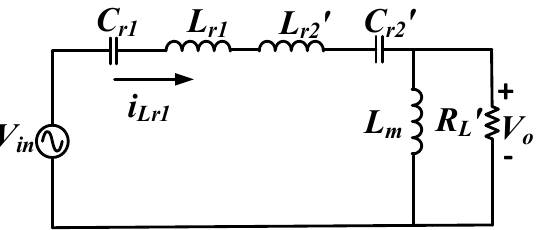
Figure 8. Simplifying the 2C3L exciting inductance position to form an LLC circuit.